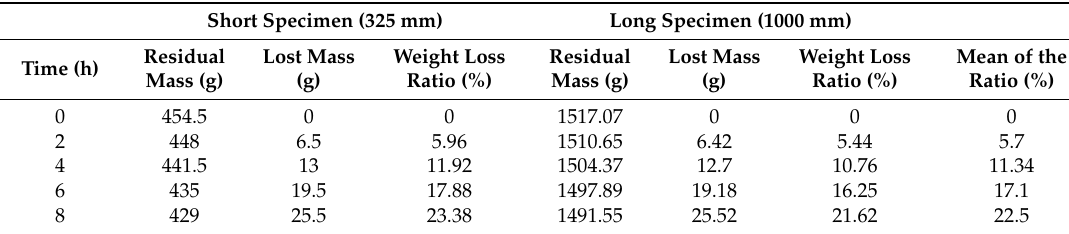
Table 2. Corrosion calibration result with 3 A